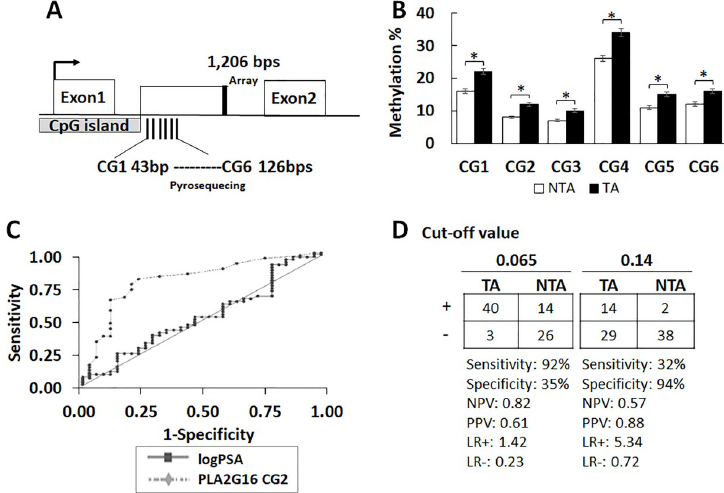
Fig 1. Methylation of PLA2G16 increases in urine samples from patients with cancer. A: Location of the PLA2G16 regions where DNA methylation was significantly altered in CytoScanHD microarray as well as detected by pyrosequencing after screening urine samples from patients with and without PC. The array probe is downstream 1,206 bps from the PLA2G16 CpG island, and pyrosequencing confirms the region to be downstream 126-43bps from the PLA2G16 CpG island, they both are within an intron. Six CGs were detected by pyrosequencing. B: PLA2G16 methylation in urine samples analyzed using pyrosequencing. The values are from 3 individual experiments, shown as percentage Mean ± SEM. All loci shown were significantly altered in TA (tumor-associated, n = 90) when compared to NTA (non-tumor-associated, n = 77) samples. Student’s t-test was used to compare the differences between two groups, � p < 0.0006. C: ROC curves were generated to validate the predictive accuracy of the binary logistic regression models for discriminating TA and NTA urine samples. When used alone, PLA2G16 CG2 (dashed curve) discriminated between patients with and without known cancer (AUC 0.798, p < 0.001). LogPSA used alone in a univariate model shown (solid curve) AUC 0.519, p = 0.20. A multivariate model incorporating logPSA and CG2 had a lower predictive accuracy (AUC 0.790, 95% CI 1.16–1.63, p = 0.001, curve not shown here) for discriminating TA vs NTA. D: PLA2G16 CG2 univariate model sensitivity, specificity, positive predictive value (PPV) and NPV. Two optimal cutoffs for predicted probabilities were used to define positive (+) and negative ( − ) test